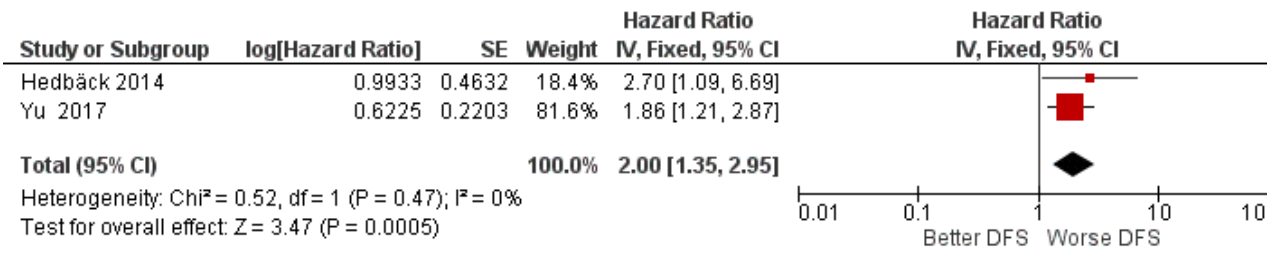
Figure 3. Forest plot of the fixed-effects model of the meta-analysis of the second outcome.